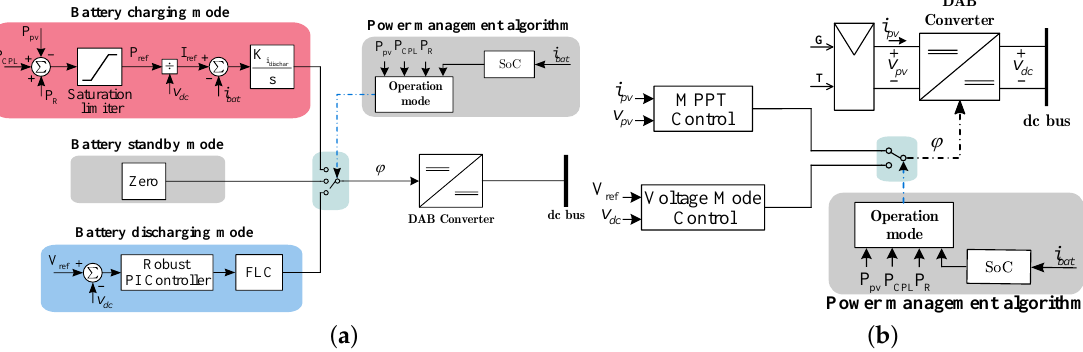
Figure 6. Control schemes for BESS and PV system. ( a ) battery energy storage system; ( b ) PV